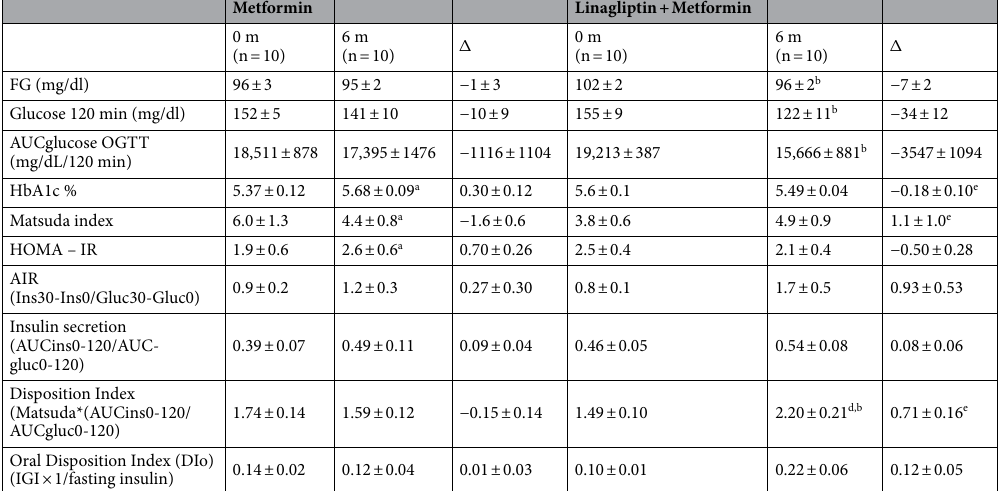
Table 3. Biochemical indicators before and after the intervention, in both groups after controlling for the baseline area under the glucose curve during OGTT. Data are Means ± SE. (cid:31) = change from baseline, AIR acute insulin response, OGTT oral glucose tolerance test, AUC area under the curve, HbA1c: glycated hemoglobin A1c. a = p < 0.05 Metformin intragroup. b = p < 0.05 Linagliptin + Metformin intragroup. c = p < 0.05 intergroup at the beginning of the study (0 months). d = p < 0.05 intergroup at the end of the study (6 months). e = p < 0.05 Delta intergroup at 6 months of study.